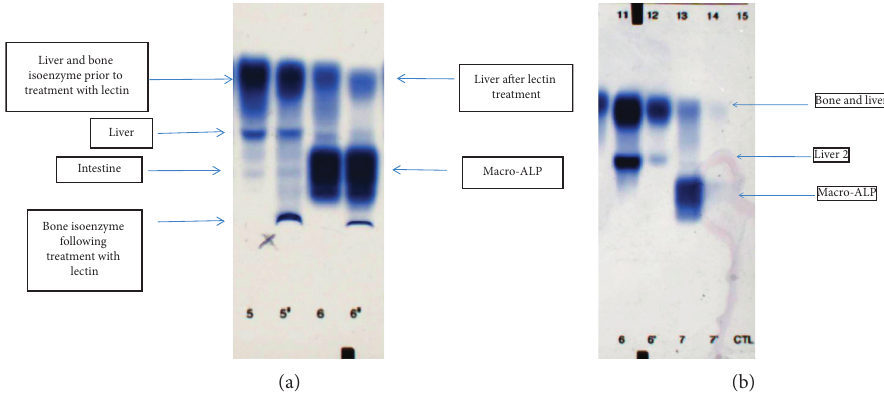
Figure 2: (a) ALP isoenzyme analysis following lectin treatment. Lane 5: Control sera with liver, bone, and intestinal isoenzyme. Lane 5 ′ : control sera following lectin treatment. Lane 6: the patient’s sera. Lane 6 ′ : the patient’s sera following treatment with lectin. Lectin precipitates the bone isoenzyme, allowing the liver isoenzyme to be quantitated. Electrophoretic mobility of the macro-ALP is not affected by lectin. (b) ALP isoenzyme analysis following PEG precipitation. Lane 6: control with liver ALP isoenzyme. Lane 6 ′ : control following treatment with PEG. Lane 7: the patient’s sera. Lane 7 ′ : the patient’s sera following treatment with PEG. PEG treatment precipitates the macroenzyme in the patient’s sera.